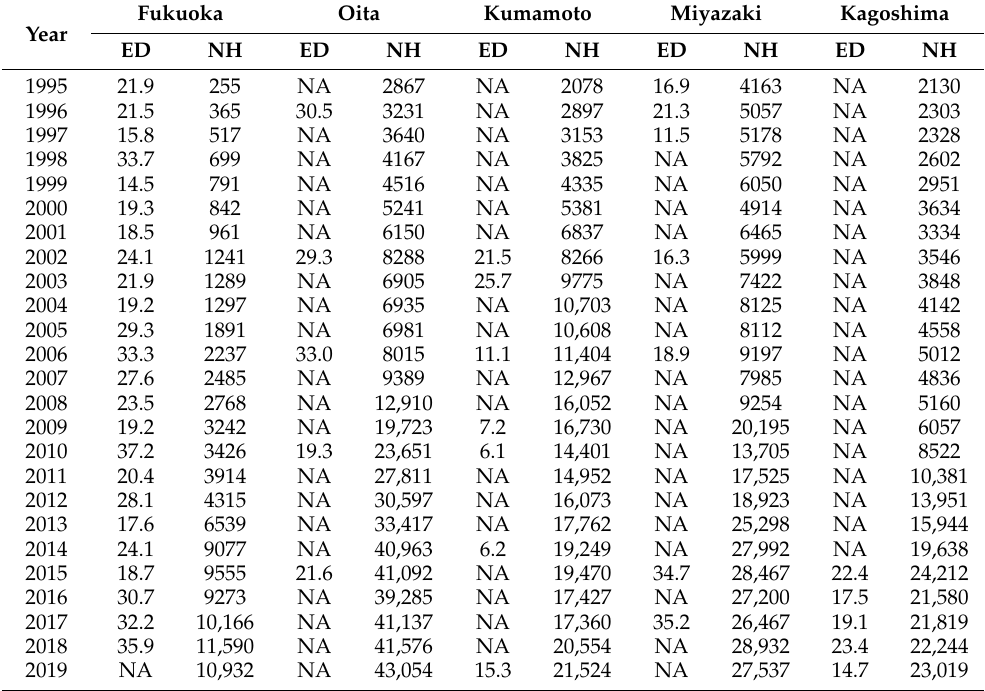
Table A1. Sika deer density estimated by fecal pellet count method (ED) and number of harvesting of sika deer (NH) in each prefecture. NA indicates nonapplicable